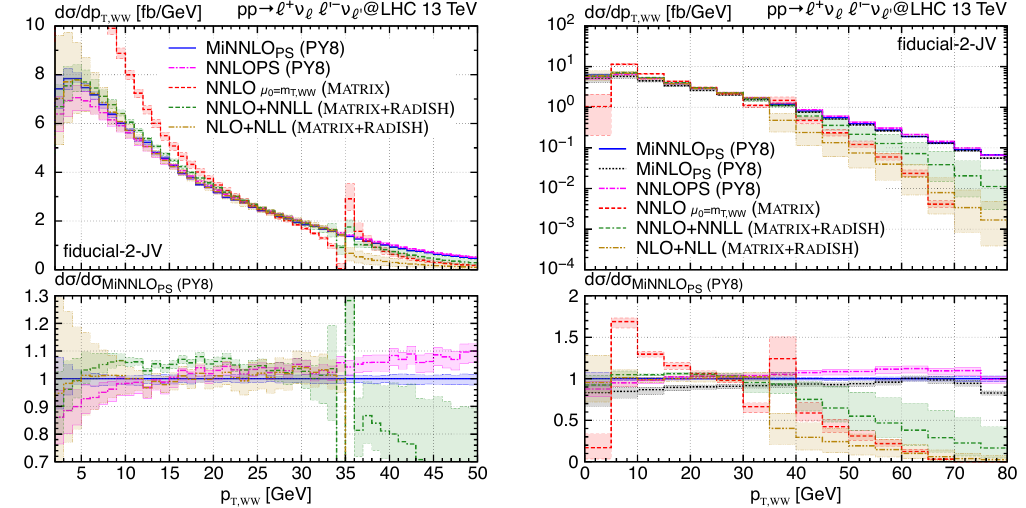
Figure 10. Distribution in the transverse momentum of the W + W (cid:0) pair in the presence of a jet veto ( fiducial-2-JV phase space), showing a smaller (left plot) and a wider range (right plot). fact that the scale uncertainties of the latter are somewhat underestimated, given that the parton shower is less accurate than the NLL calculation in that region. Another interesting region for this observable is around p values of 35 GeV, i.e. of the order of the jet-veto T, WW cut. The region p is filled for the first time at NNLO, which is effectively (cid:21) p veto T, WW T, j 1 only LO accurate, since at LO it is p . = 0 and at NLO p = p T, WW T, WW T, j 1